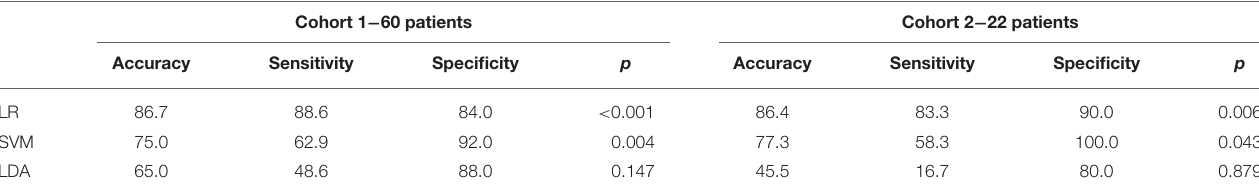
TABLE 2 | Classification performance indices for electrode group